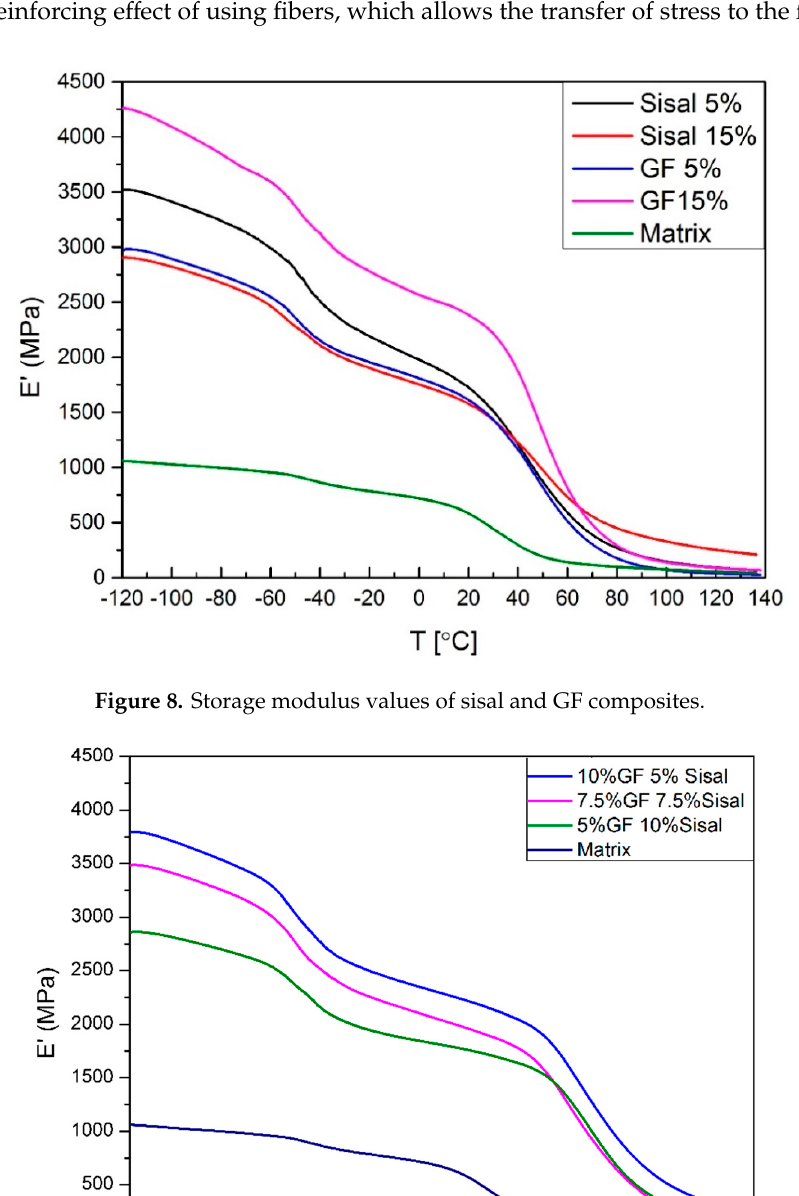
Figure 9. Storage modulus values of obtained hybrids.